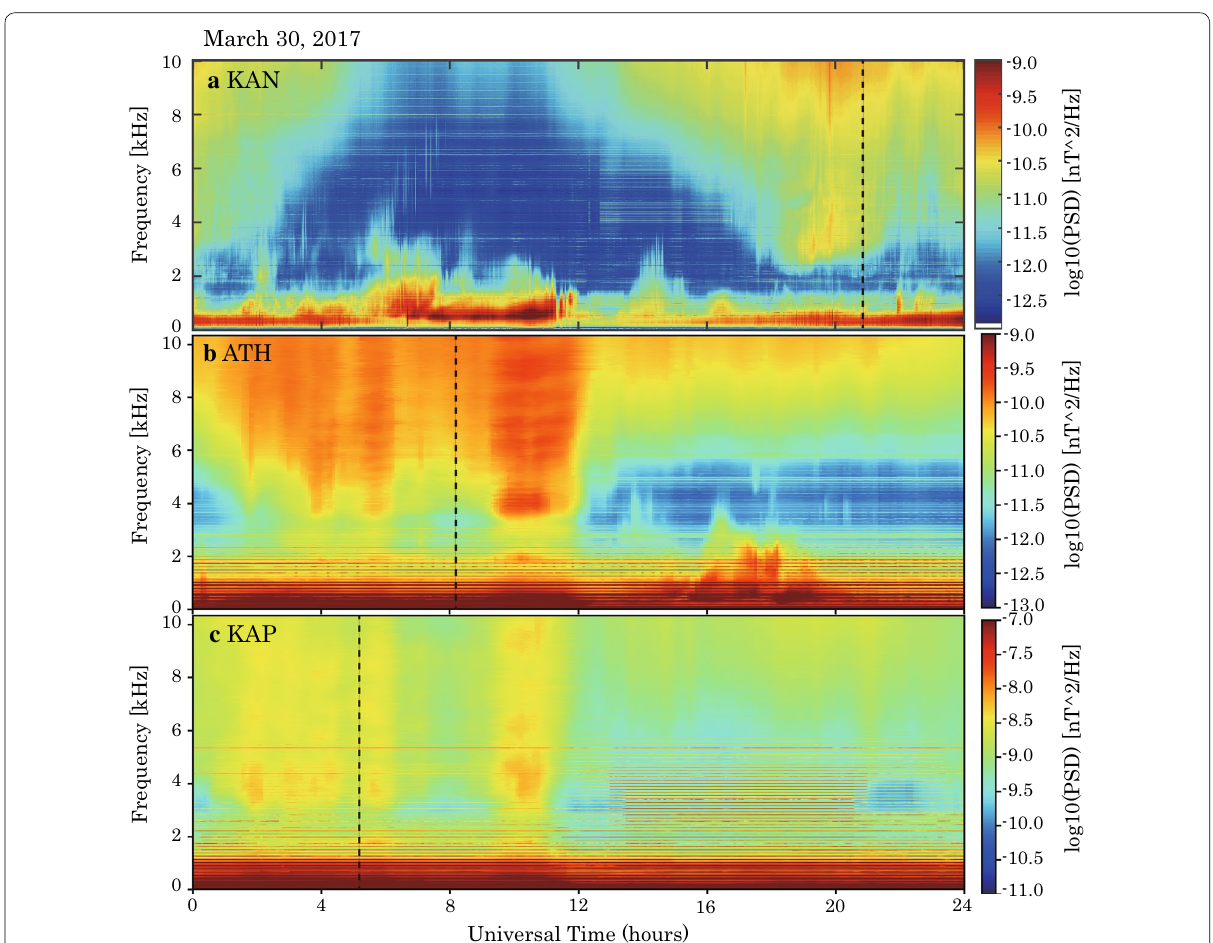
Fig. 14 Twenty‑four‑hour spectra of ELF/VLF waves (north–south magnetic field variations) observed by loop antennas at KAN, ATH, and KAP. Verti‑ cal dashed lines indicate the time of zero MLT (magnetic midnight) at each